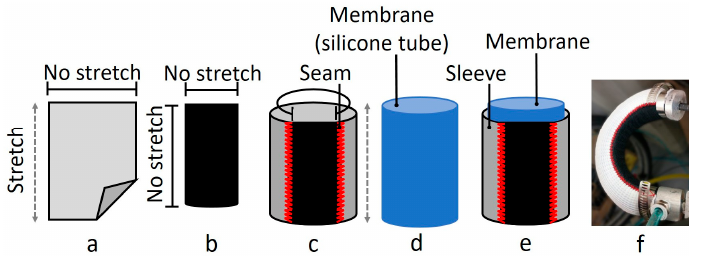
Figure 2. Assembly of a bending actuator. ( a ) Elastic band; ( b ) Strain-limiting layer; ( c ) Sleeve assembly; ( d ) Silicone tube, acting as the membrane; ( e ) Muscle assembly; and ( f ) Assembled bending muscle with end caps (pressurized).